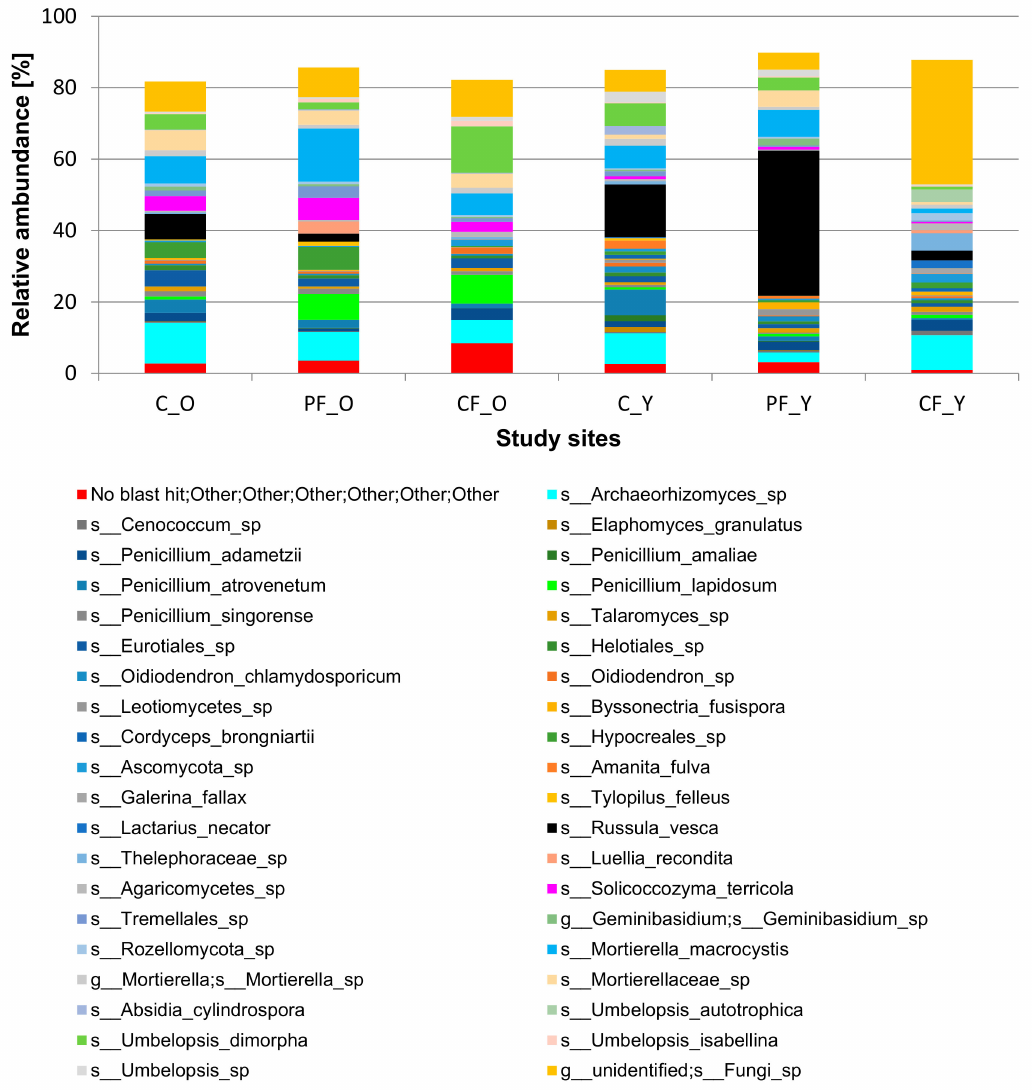
Figure 3. The relative distribution of dominant eukaryote (fungal) species in soil collected from the C—control; PF—peripheral fire; CF—central fire areas; Y—young pine stand; O—old pine stand. Note: little letter estimate: g—genus, s—species. The data represent the mean abundances from six study areas ( n = 3). OTUs are defined at 97% sequence identity threshold. Major taxa (species level) and candidate taxonomic groups detected with a relative sequence abundance ≥ 1.0% in at least one of the